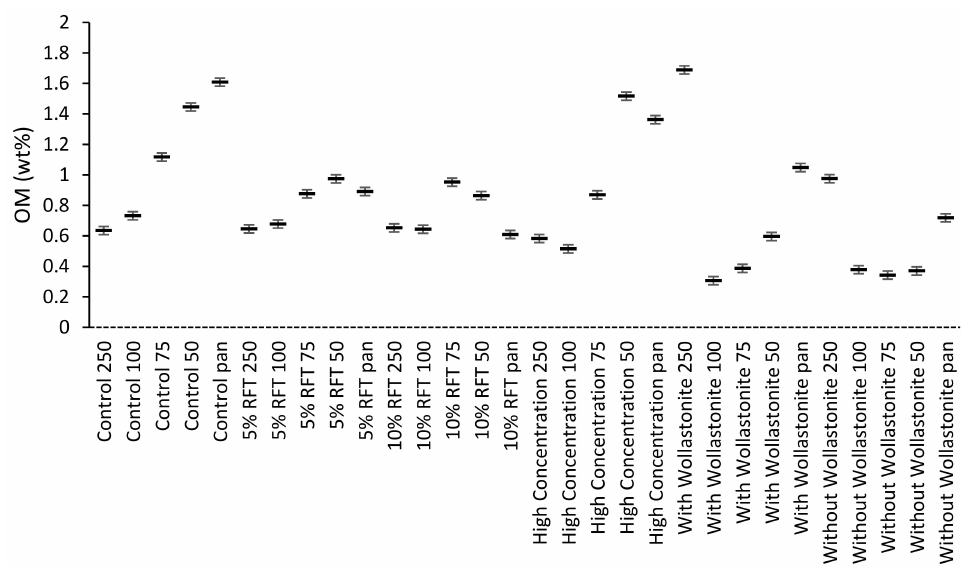
Figure 2. Organic matter (OM) content, determined by LOI, of the three di ff erent soils fractionated by dry sieving. Error bars represent the standard deviation of triplicate